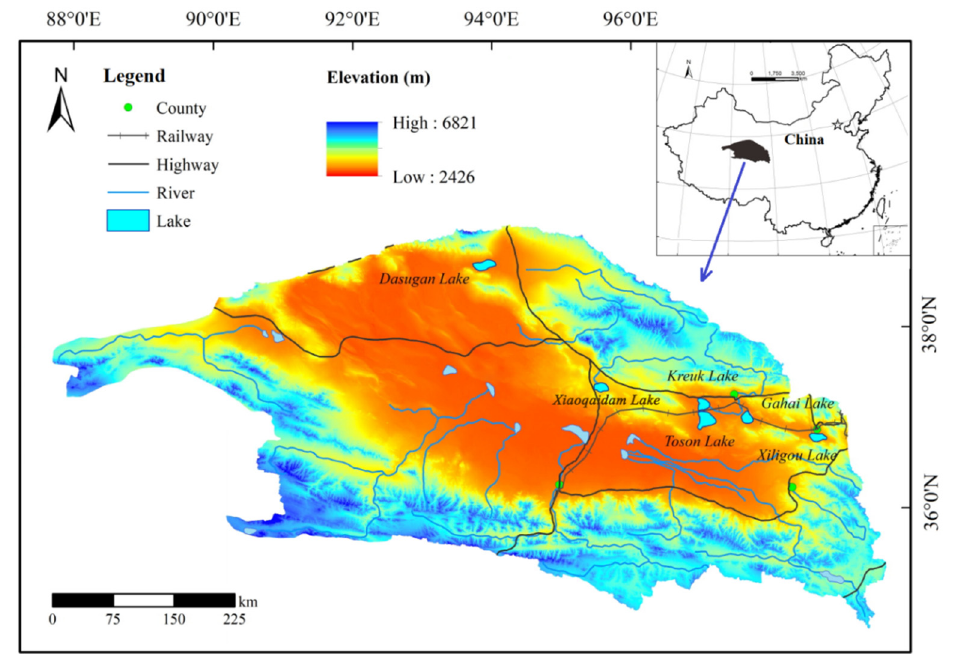
Figure 1. Overview map of the six study lakes in the Qaidam Basin.